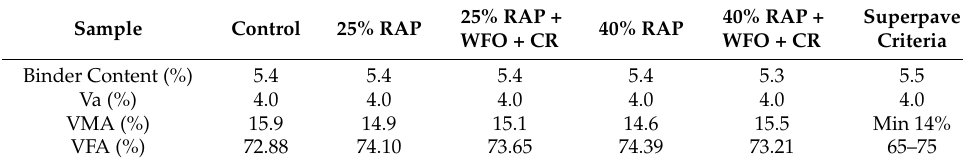
Table 9. Volumetric properties for all samples at the N design (100